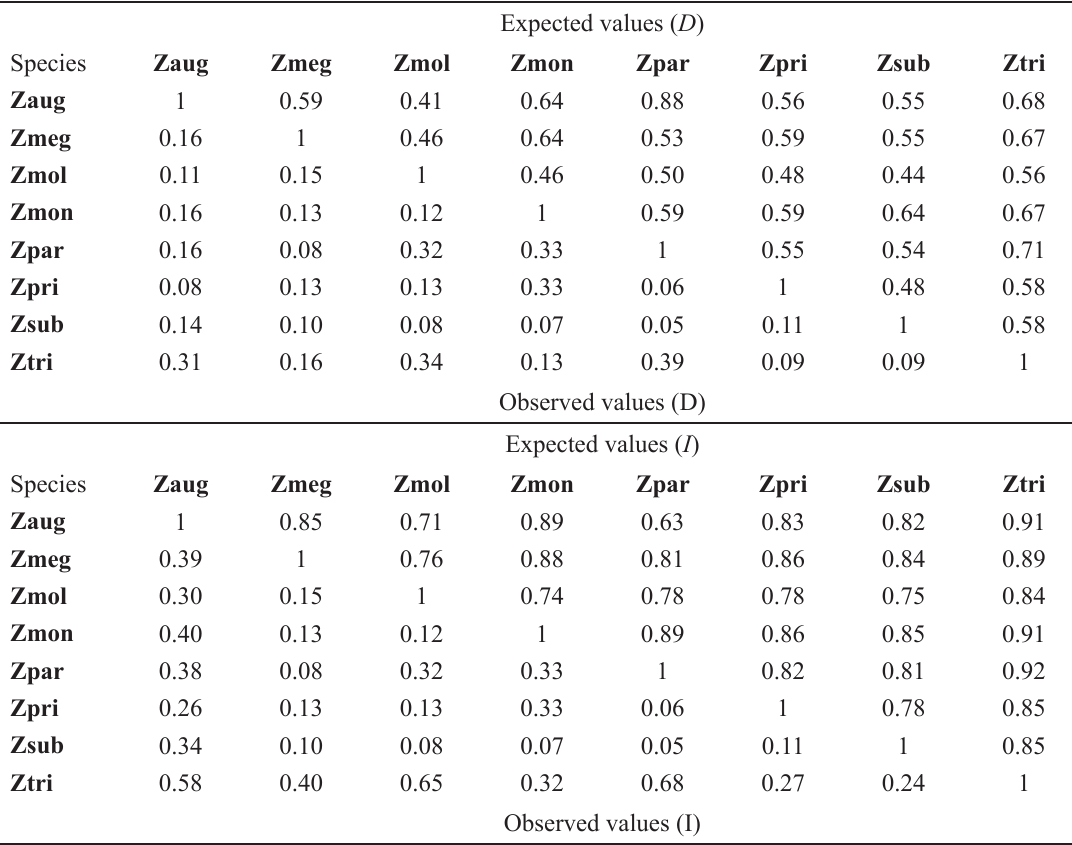
Table 4 – Overlap values of the analysed species obtained using the D = Schoener’s and I = Hellinger’s indices. The observed data values are shown below the diagonal, while the expected data are at the top. Zaug = Z. augusta , Zmeg = Z. megacephala